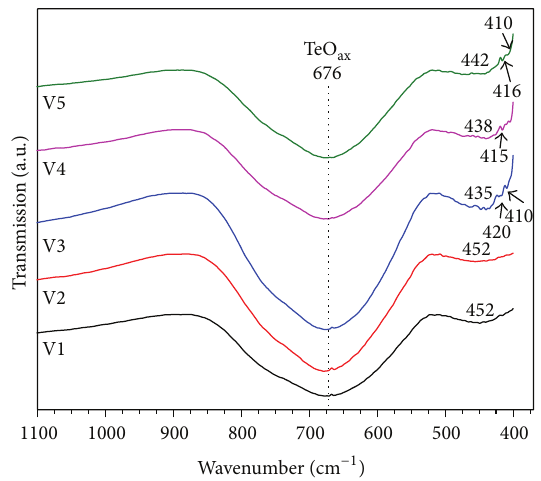
Figure 3: Infrared spectra of the obtained glasses, a broad absorp- tion band at 676 cm −1 can be identified and it corresponds to the asymmetric stretching vibrations of Te-O bonds in TeO 3